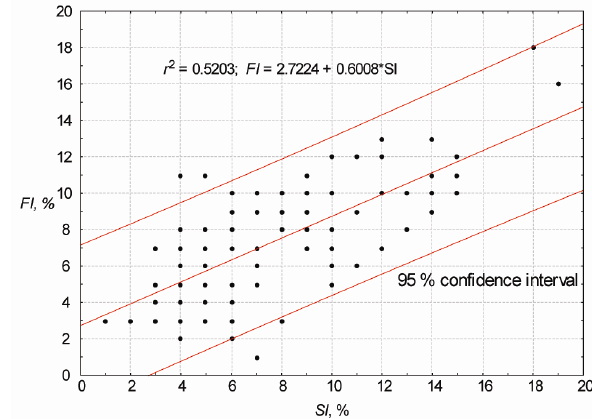
Fig. 5. Dependence between indexes FI and SI of granite, dolomite, and gravel